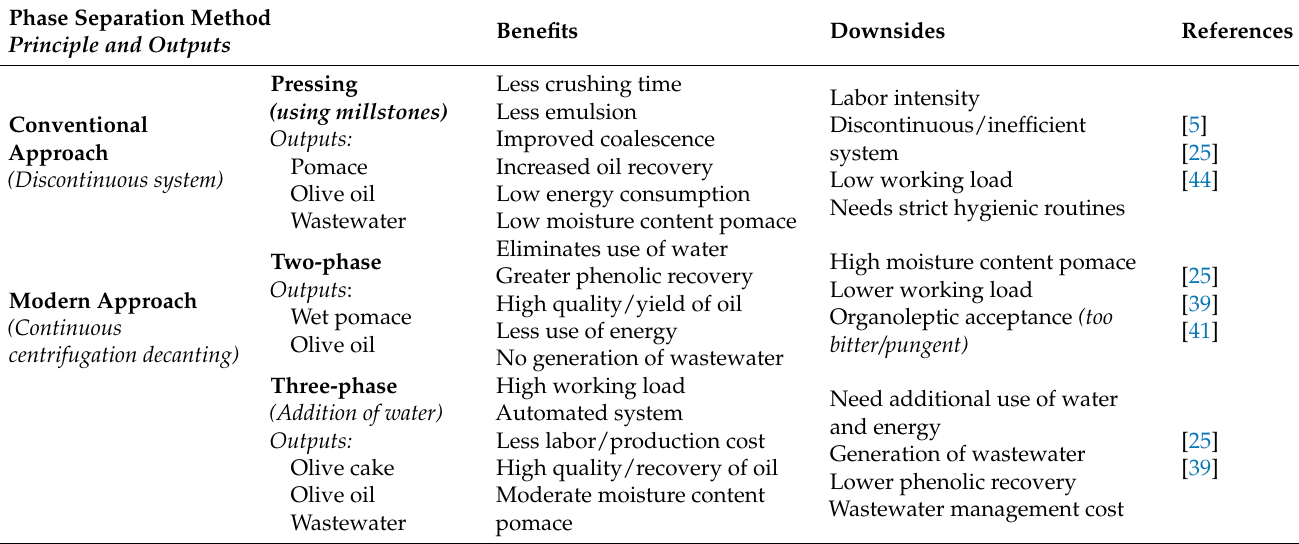
Table 1. Comparison of phase separating techniques for olive oil